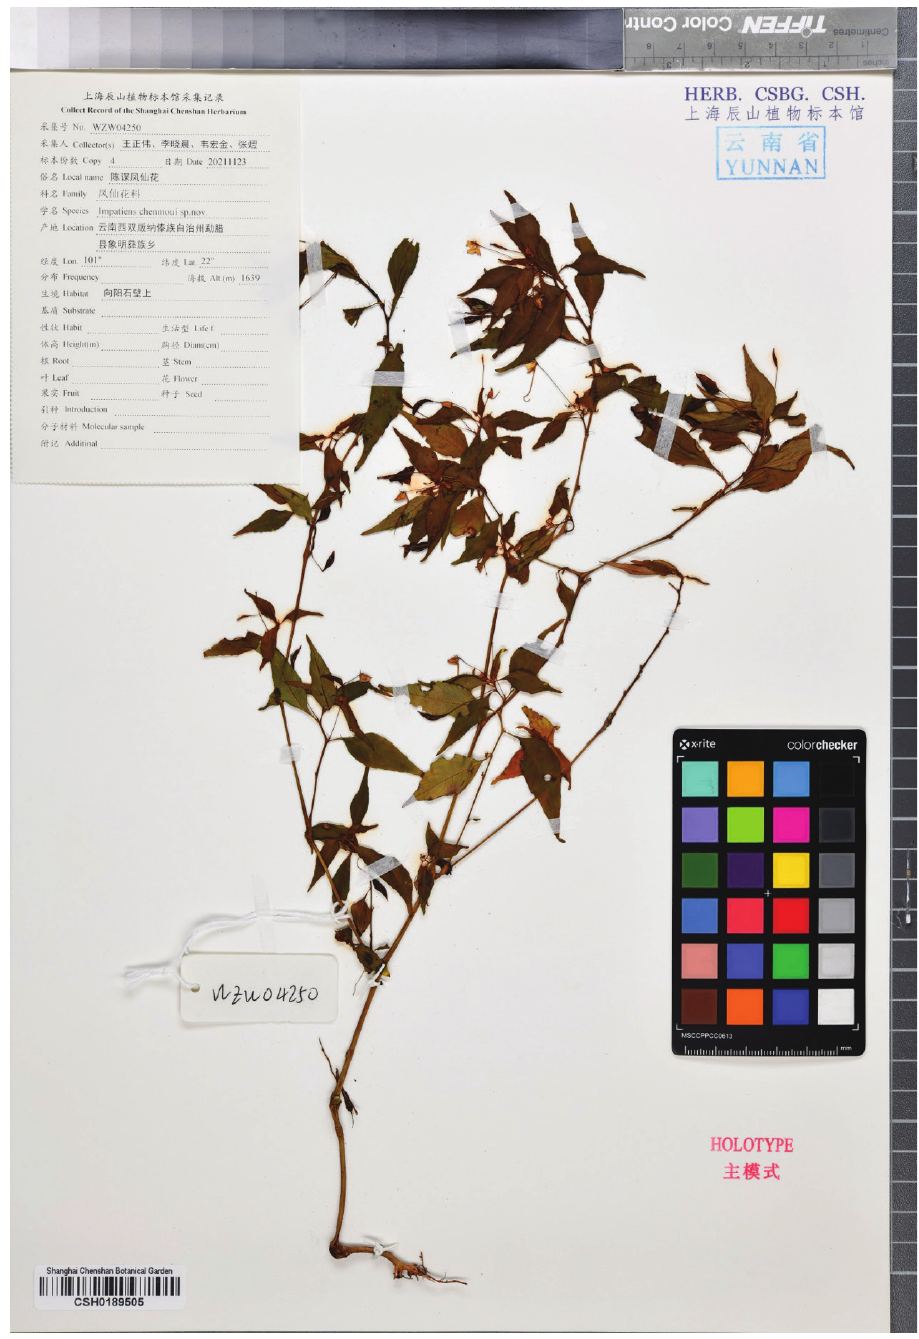
Figure A1. Holotype of Impatiens chenmoui